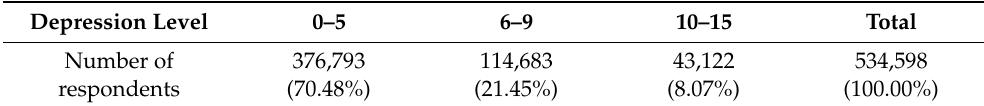
Table 2. Number of individual respondents at each depression levels.